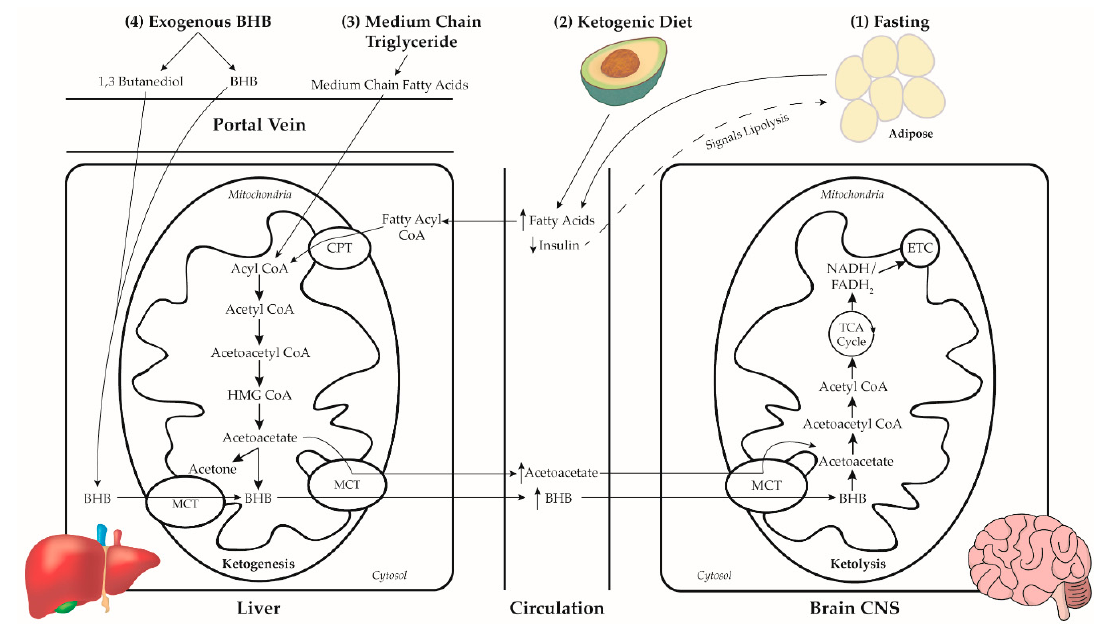
Figure 1. The major mechanisms to induce ketosis. (1) After glycogen stores are exhausted during prolonged fasting, lower levels of circulating insulin signals lipolysis of endogenous adipose, resulting in a rise in circulating free fatty acids, and ketogenesis. Fatty acids are transported into liver mitochondria for synthesis of the ketone bodies acetoacetate, β -hydroxybutyrate, and acetone to a lesser degree. Ketone bodies are transported out of the mitochondria via monocarboxylate transporters (MCT) 1 and 2, enter circulation, and enter extra-hepatic mitochondria via the same MCT 1 and 2 for ketolysis. Ketone bodies are retroconverted to acetyl CoA, enter the citric acid (TCA) cycle for ATP production, and the resulting NADH and FADH2 facilitate energy production via the electron transport chain (ETC). (2) The KD’s exogenous fat substrate and restricted carbohydrate initiates an action similar to fasting by increasing circulating fatty acids and reduced insulin. During a KD, both exogenous and endogenous fatty acids are destined for ketogenesis. (3) Medium chain triglycerides are gastrointestinally digested to medium chain fatty acids, absorb across the intestinal lumen, and rapidly enter the liver via the portal vein, bypassing the lymphatic system and peripheral circulation. Medium chain fatty acids enter the ketogenesis pathway at the level of acetyl CoA. (4) Exogenous β -hydroxybutyrate esters are cleaved into β -hydroxybutyrate and 1,3 butanediol by local gut esterases. Both products enter the liver via the portal vein, enter mitochondria at the β - hydroxybutyrate or acetoacetate level of ketogenesis, and enter circulation as β -hydroxybutyrate or acetoacetate.